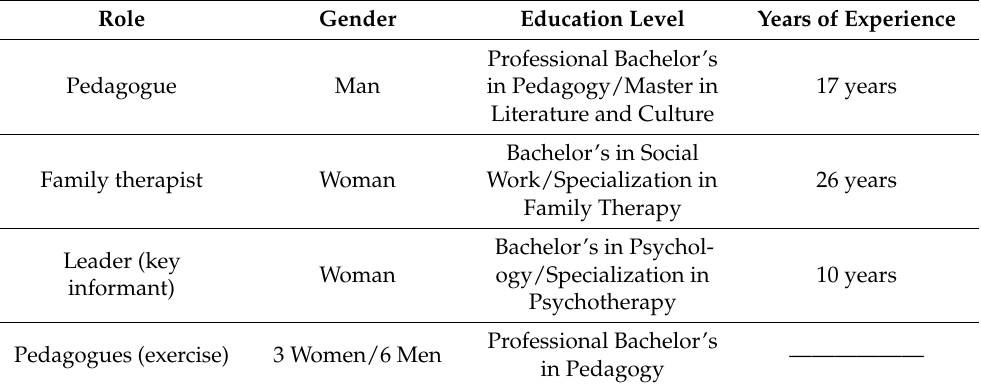
Table 1. Background information of the